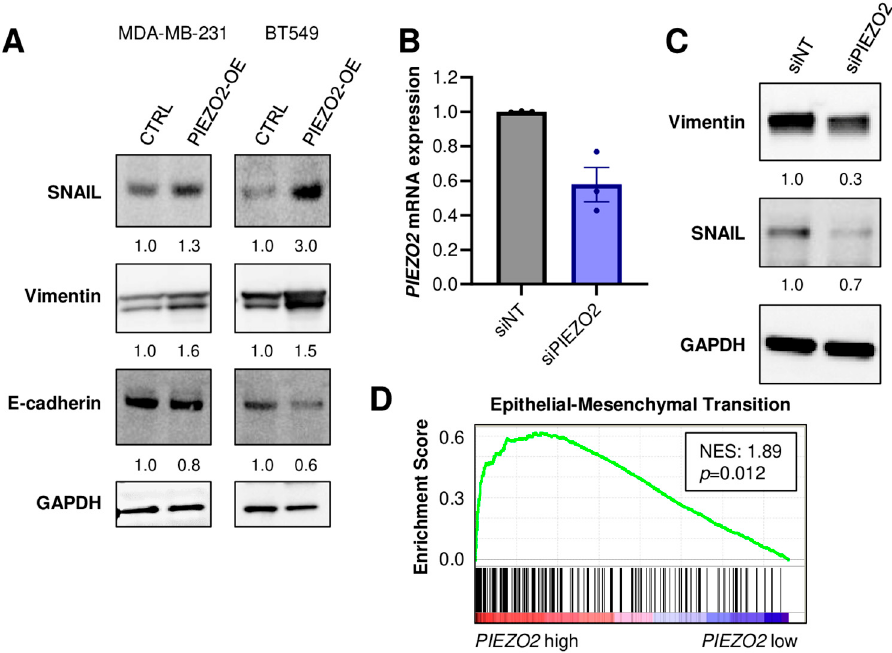
Figure 3. PIEZO2 level leads to expression changes of genes associated with invasion and metastasis in TNBC. ( A ) Western blotting of SNAIL, Vimentin, E-cadherin, and GAPDH in control (CTRL) and PIEZO2 overexpressed (PIEZO2-OE) MDA-MB-231 and BT549 cells. ( B ) PIEZO2 mRNA quantified by qPCR in siRNA non-targeted (siNT) or for PIEZO2 (siPIEZO2)-transfected MDA-MB-231 cells. ( C ) Western blot of Vimentin, SNAIL, and GAPDH in control (siNT) and PIEZO2 knockdown (siPIEZO2) MDA-MB-231 cells. ( D ) Gene-set enrichment analysis comparing PIEZO2 high- and low-expressing TNBCs in TCGA cohort.